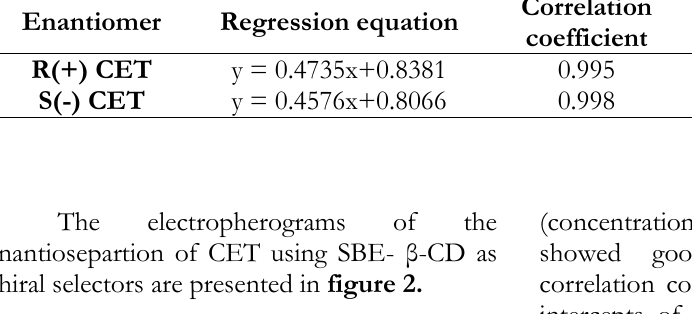
Table I Calibration data for CET chiral separation (calibration range: 2.5 - 50 µg mL -1 )